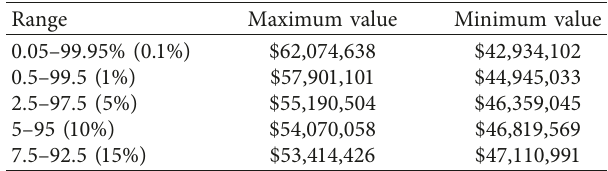
Table 4: Valuables used for calculating option value. Table